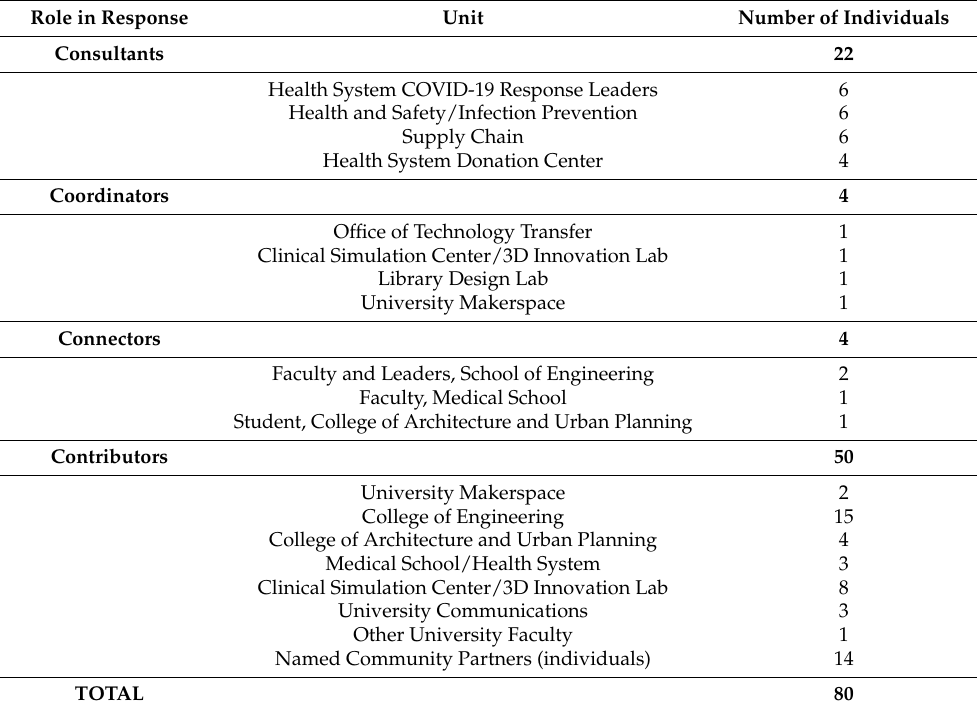
Table 2. Number of individuals by unit affiliation and role in the face shield response, as described by questionnaire